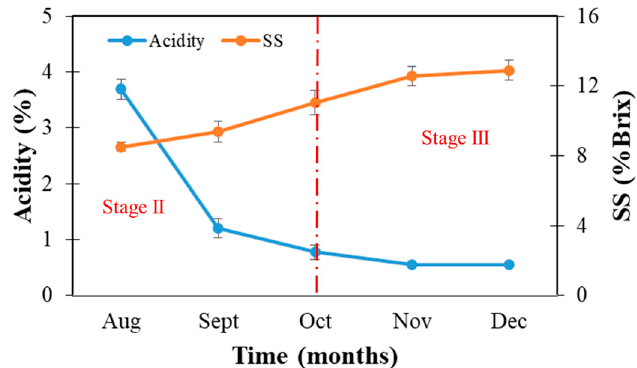
Figure 6. Soluble solids (SS) and acidity (as % citric acid) during the growth and maturing stages.